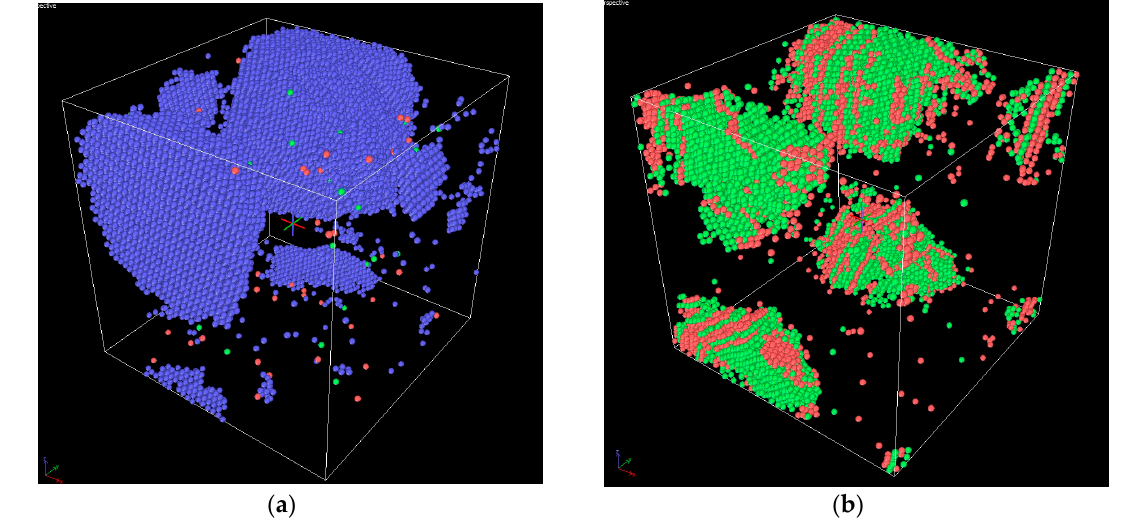
Figure 7. Growing crystalline particles ( a ) of BCC Fe at 900 K (blue) and FCC Cu (green) at 850 K ( b ). HCP stacking faults are shown in red.